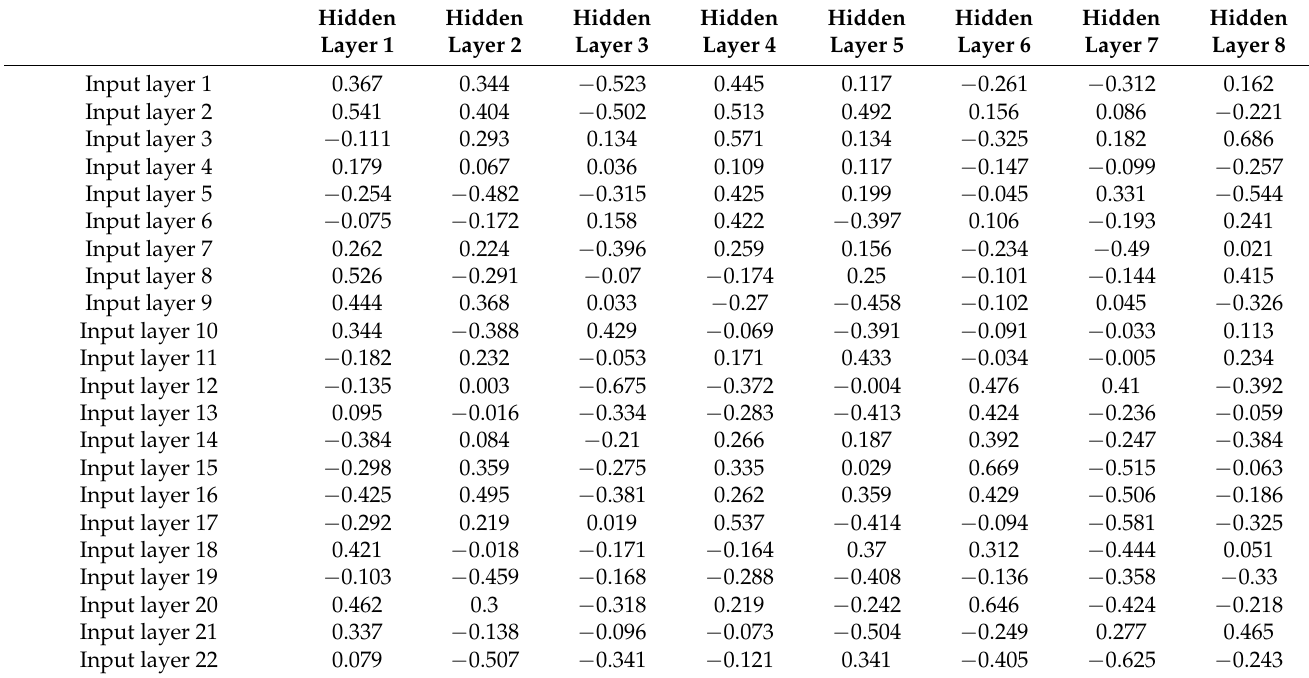
Table 12. The connection weight matrix.